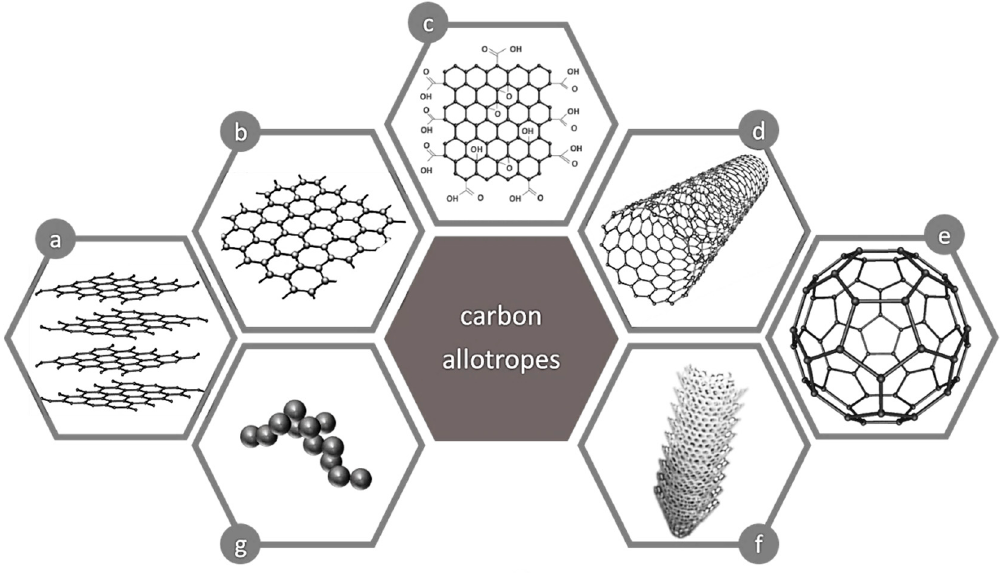
Figure 7. Carbon allotropic forms: ( a ) Graphite, ( b ) graphene, ( c ) graphene oxide, ( d ) carbon nanotube, ( e ) fullerene, ( f ) carbon nanofibers, ( g ) carbon dot.